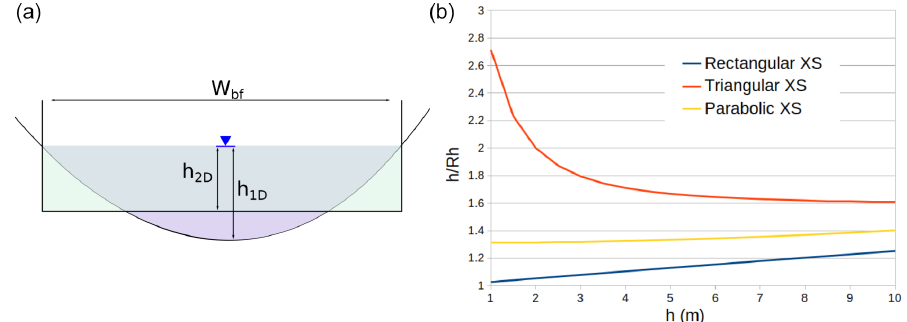
Figure 2. Equivalency of 1D and 2D flow states at equilibrium (permanent uniform flows): effective friction and bathymetry. (a) Equivalency between a 1D idealized XS (blue) and a 2D single-cell rectangular XS (green), with the same flow section A and WS elevation. (b) Variation in the hydraulic radius R h (h) for three XS shapes (of similar dimensions). This showcases the potential over- and underestimation of state variables using “1D-like equivalent friction” from Eq. (2).